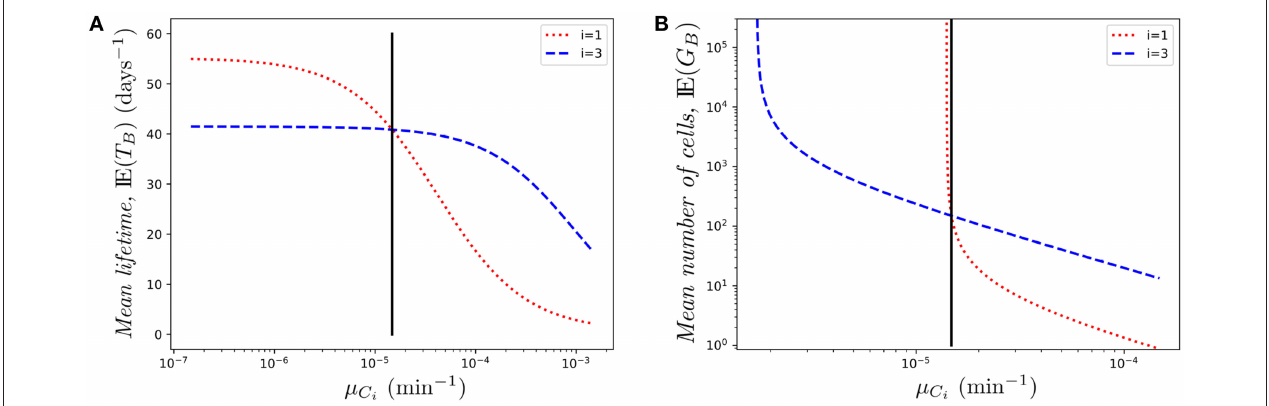
on (A) the mean lifetime, IE( T B ), and (B) the mean number of cells in the genealogy, IE( G B ), for a cell i